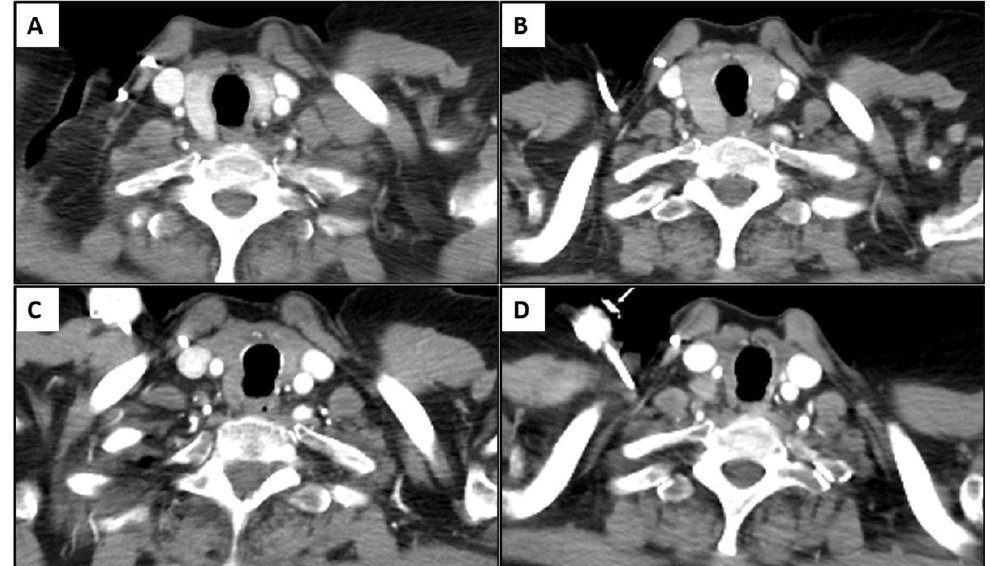
Figure 5. Representative case of temporal change in immune-related thyroiditis. A 70-year-old female with advanced lung cancer treated with ipilimumab and pembrolizumab combination therapy. There was interval enlargement of thyroid gland with diffuse hypoattenuation ( B ) compared to the baseline study ( A ) after 3.9 weeks of therapy. On follow-up scan after 12 weeks of therapy ( C ), the gland became atrophic and progressed in serial follow ups. End-of-therapy scan (after 2 years of therapy) showed significant atrophy of gland ( D ). The patient experienced transient thyrotoxicosis followed by hypothyroidism which required hormone